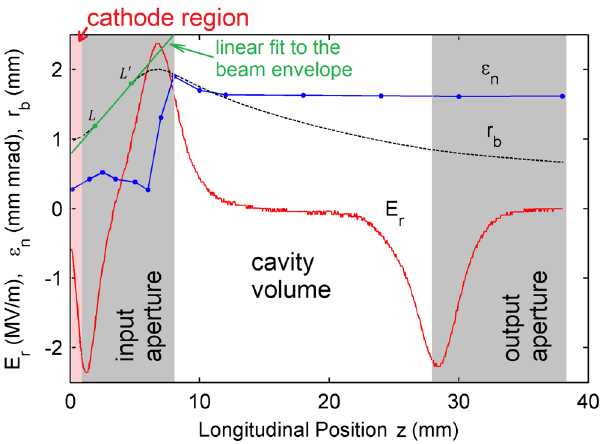
FIG. 12. The normalized rms emittance in mm mmrad (blue curve with dots), the beam envelop in mm (dotted black) and radial electric field distribution at r ¼ 1 mm in MV = m (solid red) vs. the longitudinal position. The results are obtained with EGUN